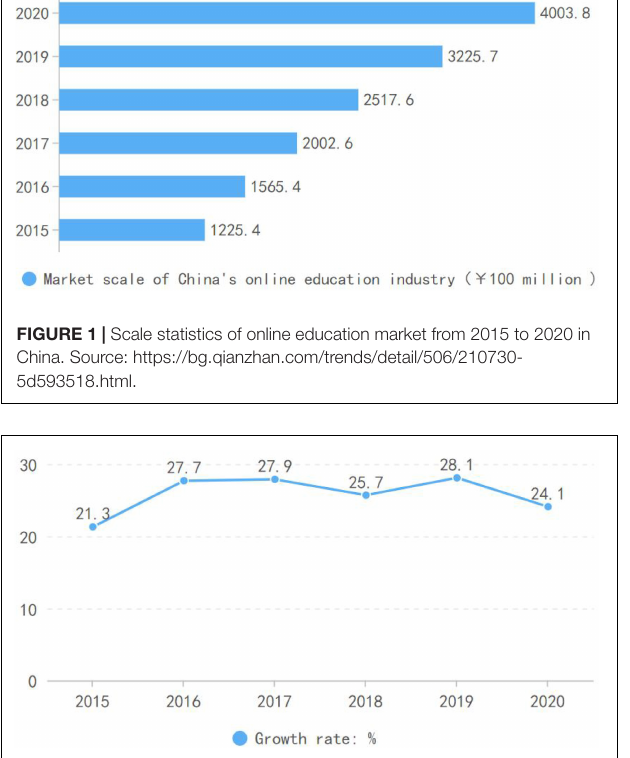
FIGURE 2 | Growth rate of online education market from 2015 to 2020 in China. Source: https://bg.qianzhan.com/trends/detail/506/210730-